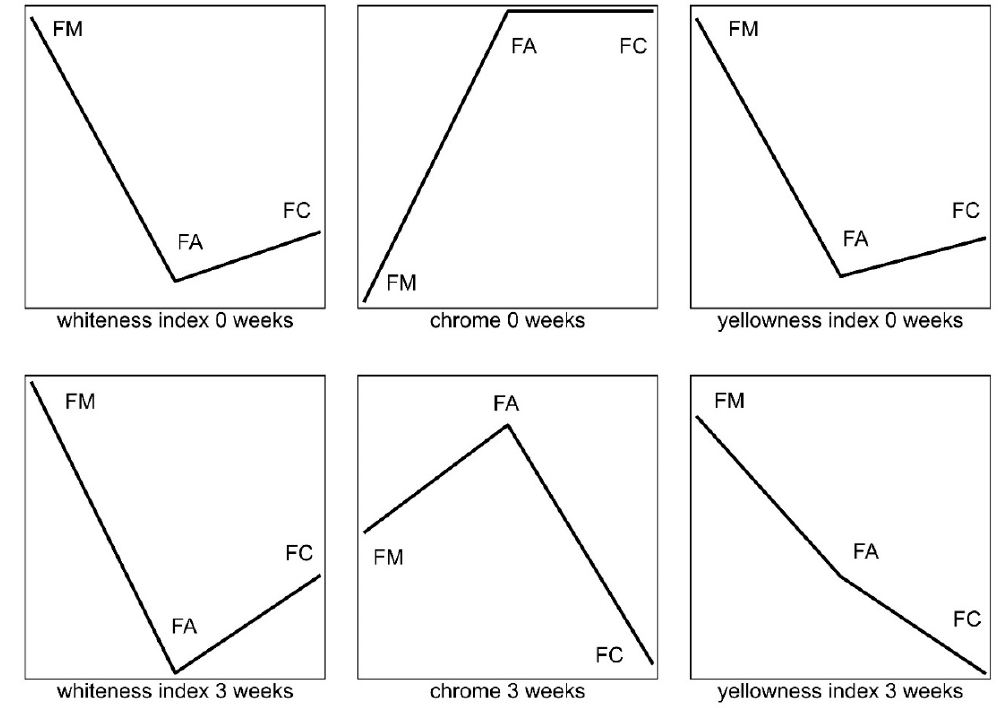
Figure 1. Graphic representation of changes in color indices due to storage (3 weeks) of